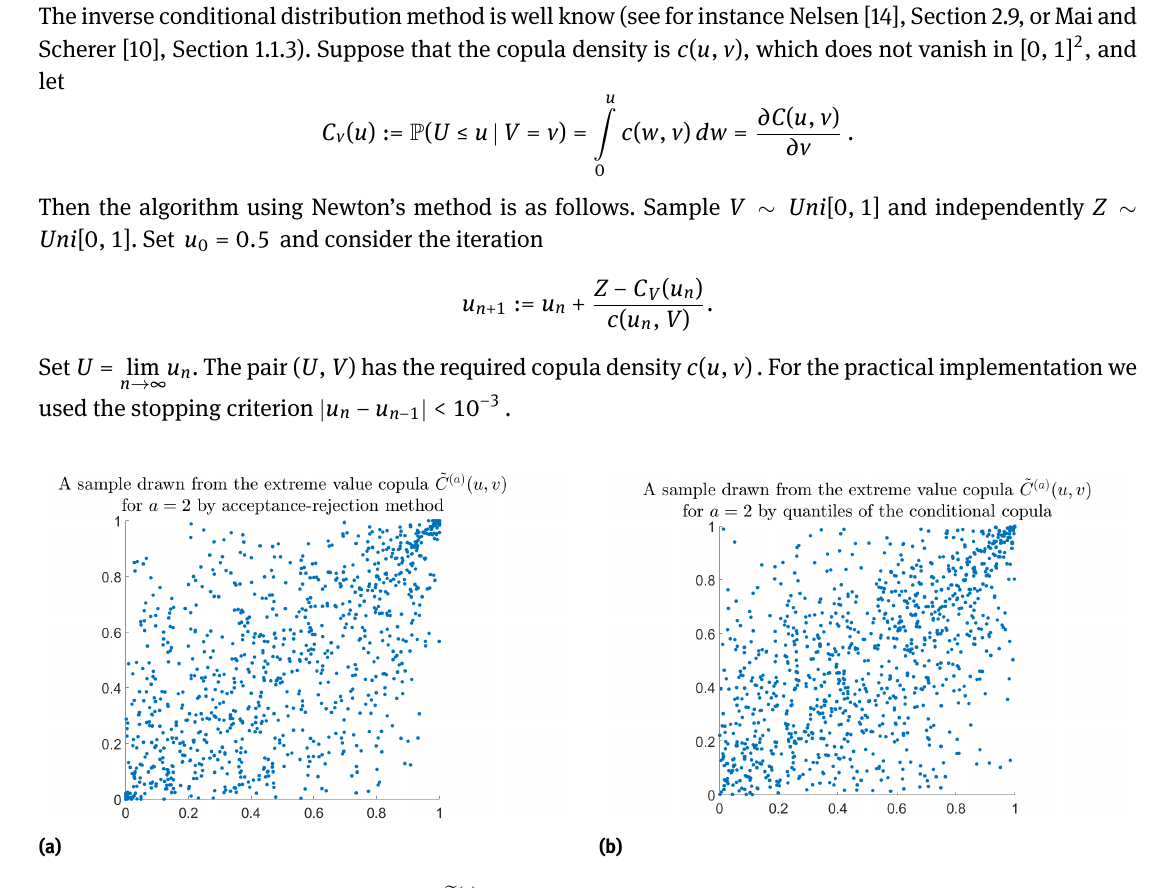
Figure 5: Two samples of size 1000 drawn from (cid:101) C ( a ) ( u , v ) by two different